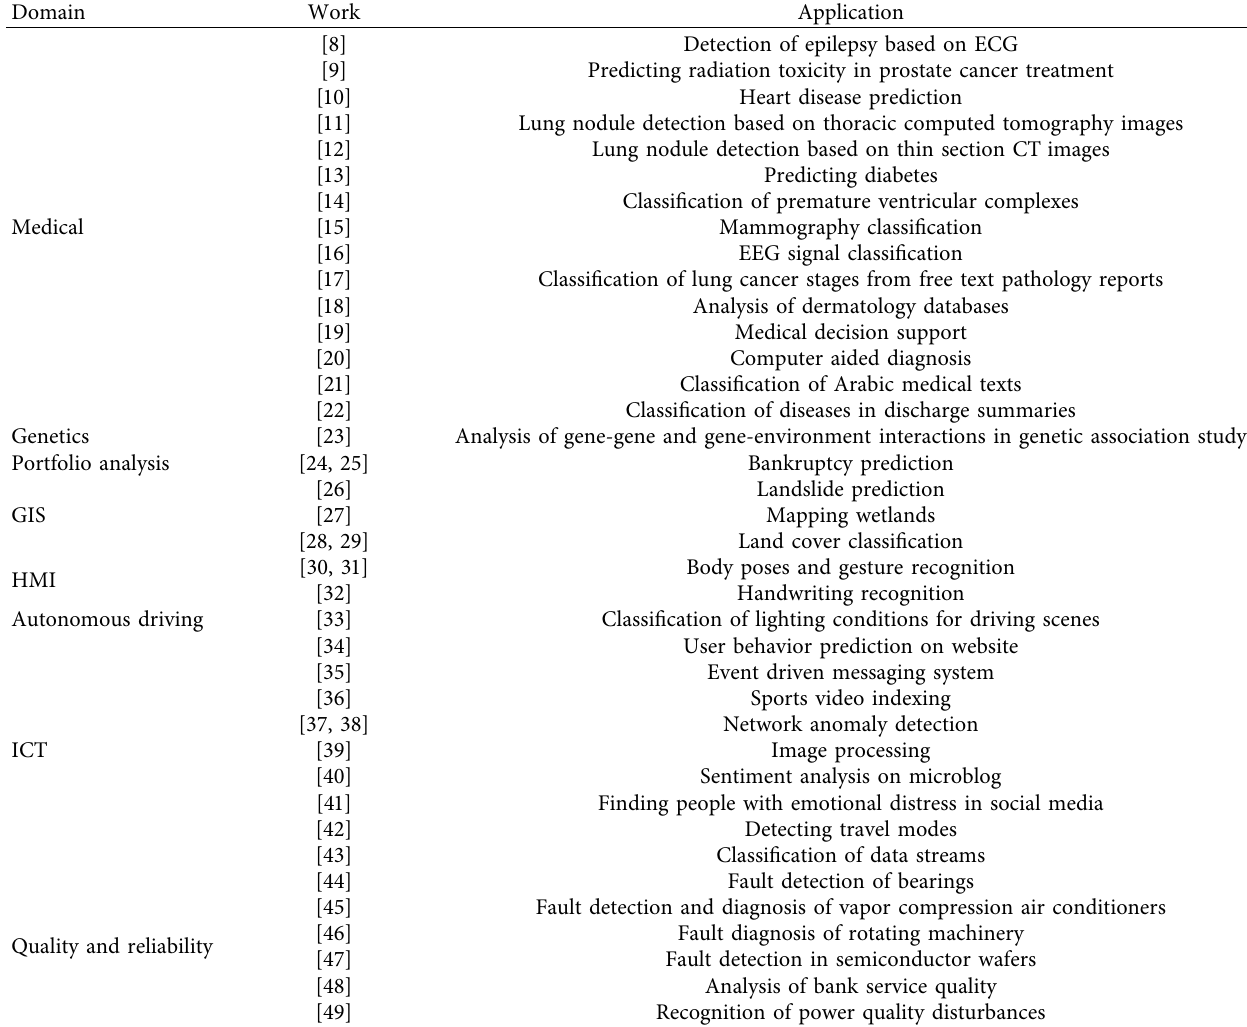
Table 2: Applications of rule-based